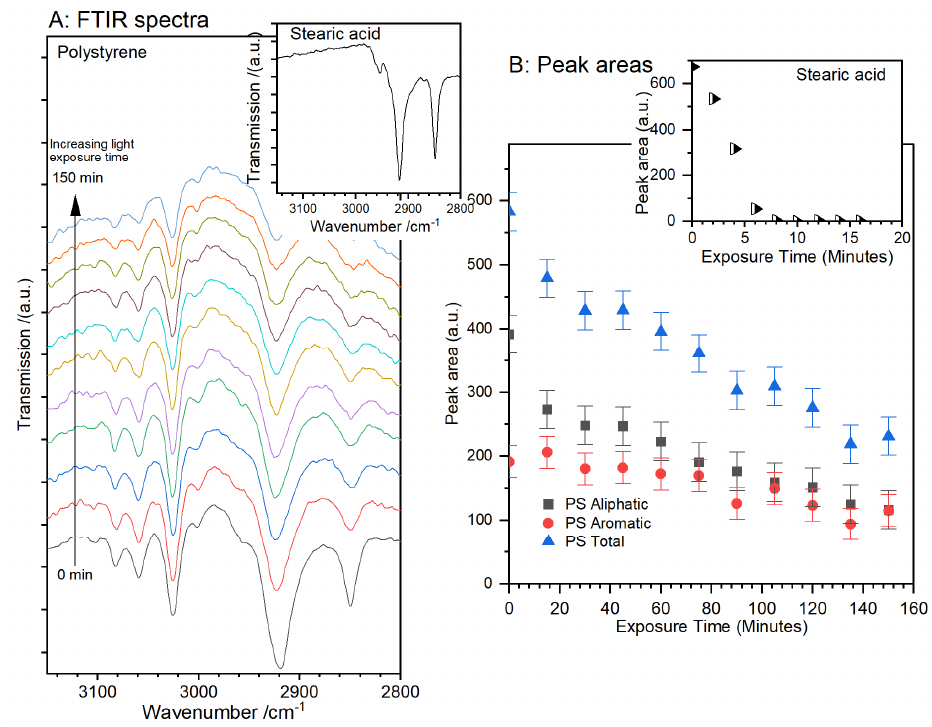
Figure 1. ( A ) Example experiment showing the effect of exposure to 365 nm light on the ν(C−H) intensity for a polystyrene film deposited on a porous Cu-doped TiO 2 film, spin coated at 2000 rpm; inset: a typical FTIR spectrum of stearic acid before photodecomposition. ( B ) Effect of irradiation on total ν(C−H) for polystyrene films with the contributions from the aliphatic and aromatic CH bonds shown separately. Inset: equivalent experiment with a stearic acid film. The calculated zero order ½ lives for stearic acid and polystyrene are ~250 s and 12,000 s, respectively.